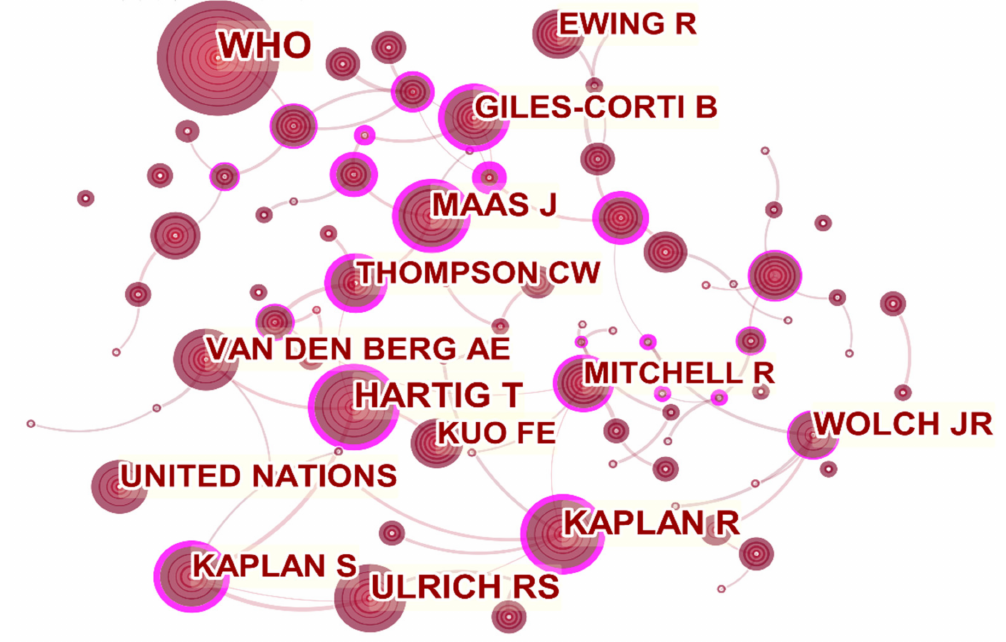
Figure 9. Visualization map of co-cited authors participating in healthy urban planning